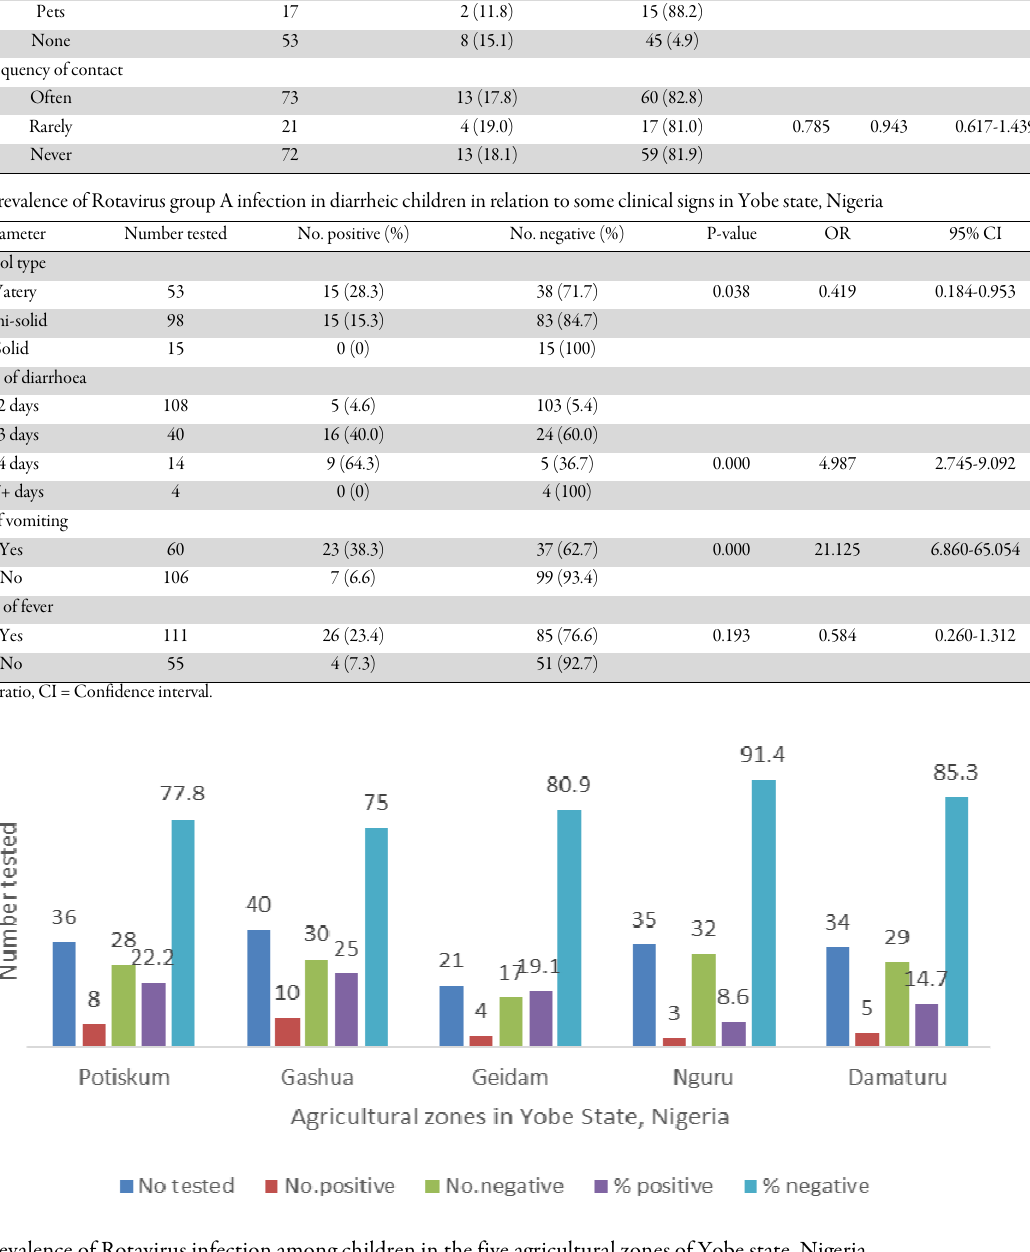
Fig. 1. Prevalence of Rotavirus infection among children in the five agricultural zones of Yobe state,